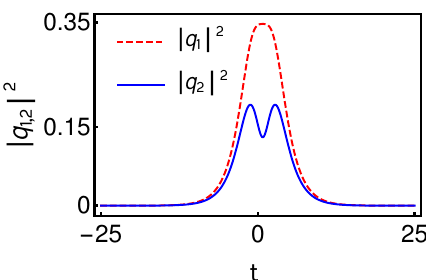
Figure 12. A typical degenerate bright soliton profile in the 2-CCNLS system is drawn for the values γ = 2, k 1 = 0.5 + 0.5 i , α 1 = 0.72 + 0.5 i and β 1 = 0.5 − 0.42 i .